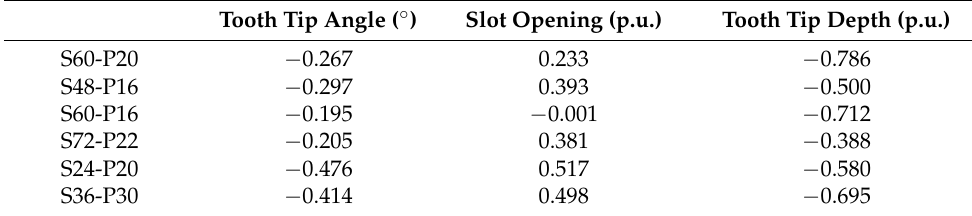
Table 8. Correlation analysis of the slot opening parameter and AC losses. Tooth Tip Angle ( ◦ )